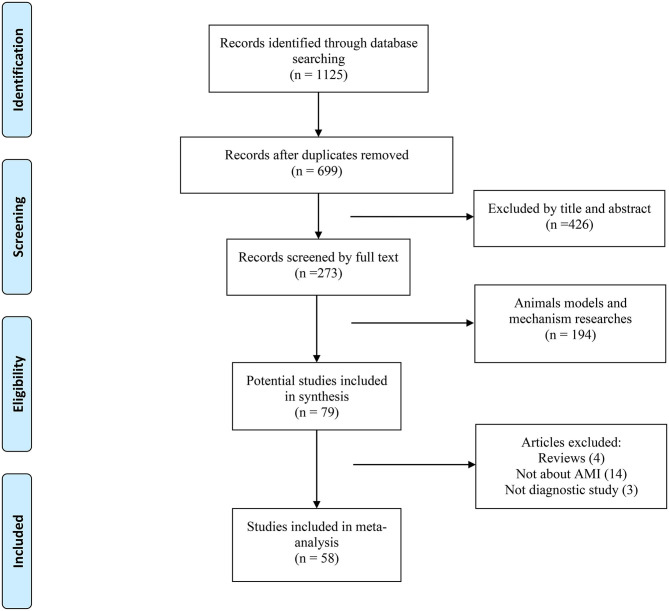
Flow diagram of the literature search process and study inclusion.